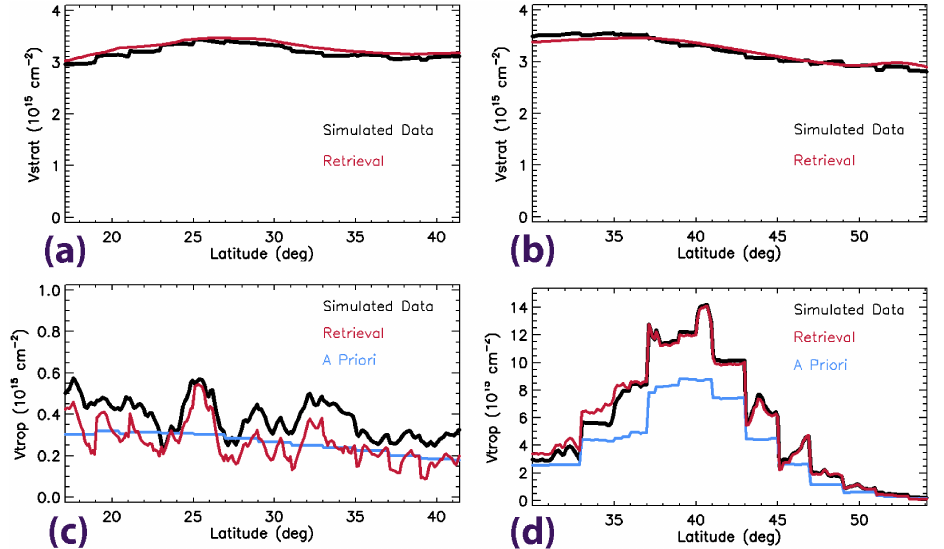
Fig. 5. NO 2 vertical-column retrievals (red), using simulated data (black). The mean value of the tropospheric data (truth, black) was defined to be larger than that of the algorithm’s a priori troposphere (blue). Shown are nadir pixels along two orbital segments: (a) and (c) are stratosphere and troposphere, respectively, for an unmasked segment in the eastern Pacific; (b) and (d) are stratosphere and troposphere, respectively, for a masked segment over eastern North America. In these simulations, geolocation, viewing geometry, and cloud parameters were taken from two orbits on 21 March